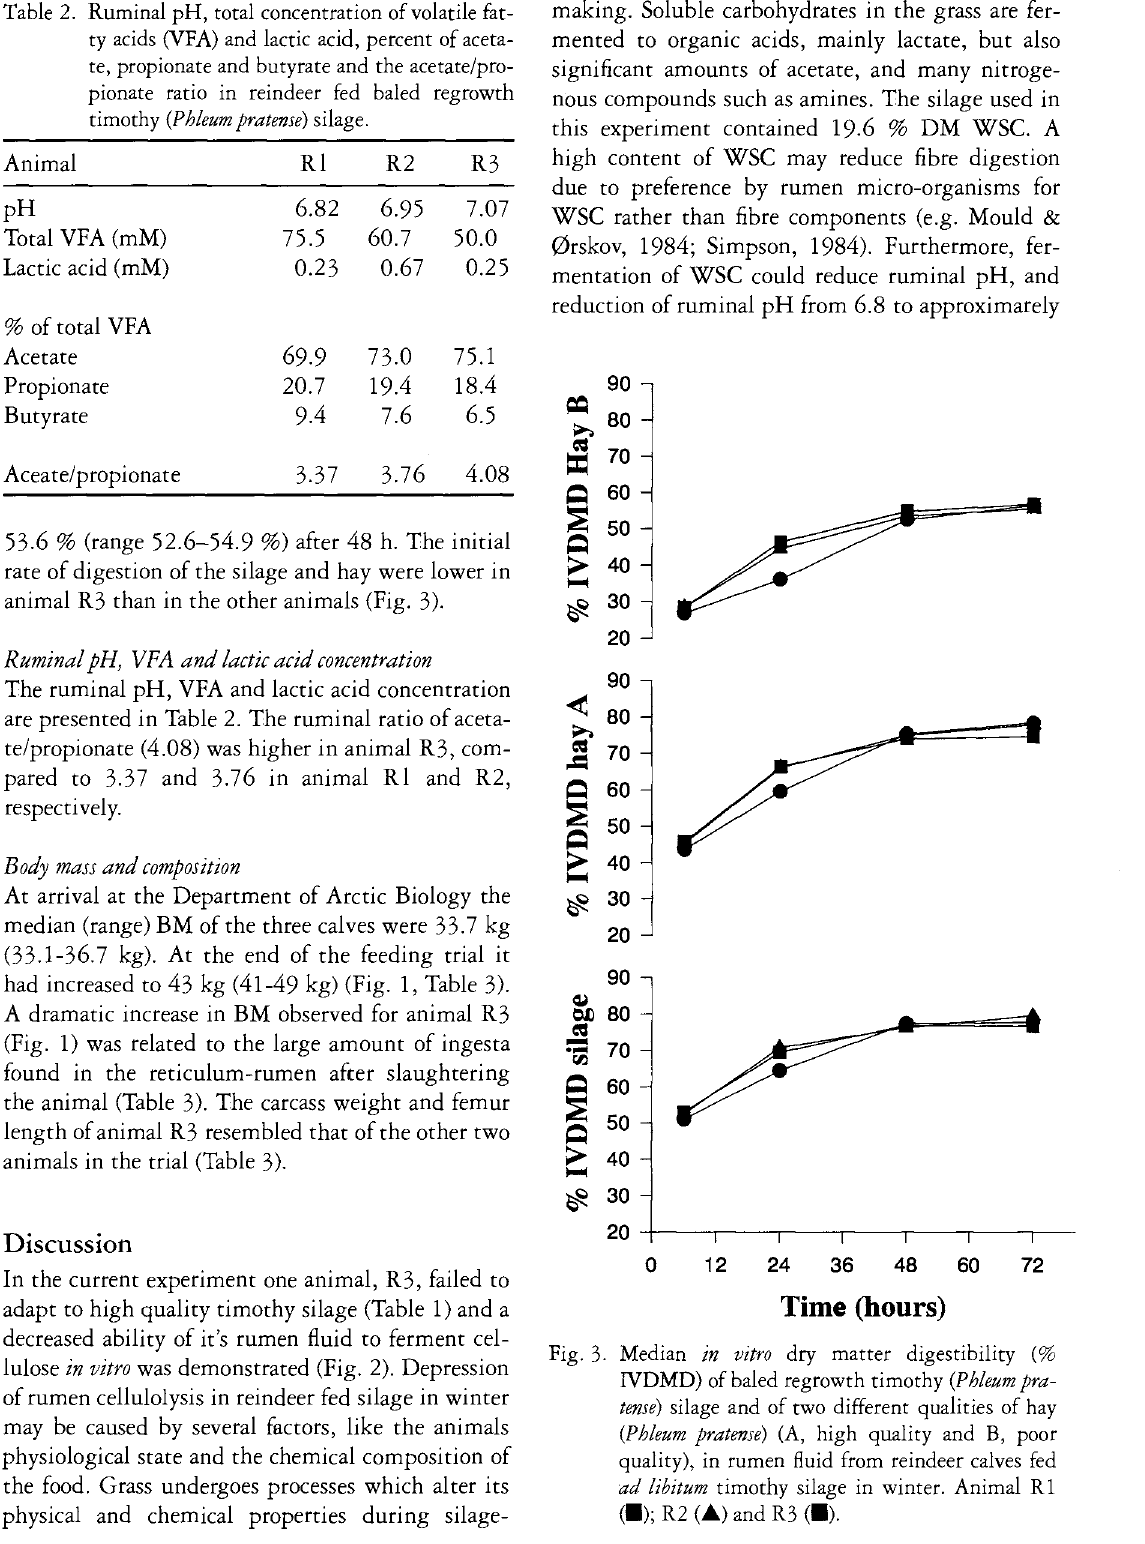
Fig. 3. Median in vitro dry matter digestibility (% IVDMD) of baled regrowth timothy (Phleum pra tense) silage and of two different qualities of